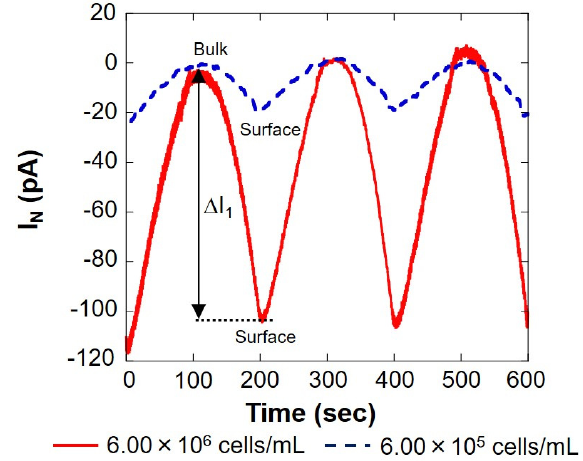
Figure 3. Changes in respiration activity with somatic cells. I N : relative value of oxygen reduction current in bulk, which was set at 0 nA. Table 1. Evaluation of somatic cells with inverted cone-shaped wells. The oxygen reduction current value difference between bulk and surface ( ∆ I) from Figure 3. The difference in oxygen reduction current was calculated using values at bulk ( − 1.76 nA) and oxygen concentration (248 µ M). Cell Number